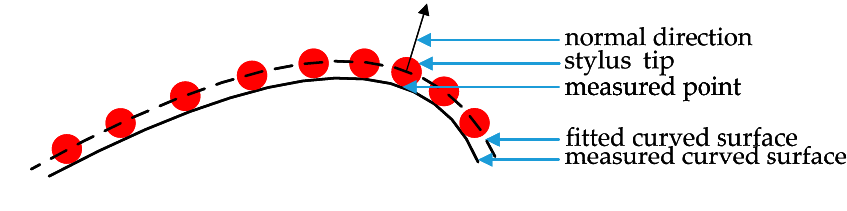
Figure 4. Tip radius compensation.